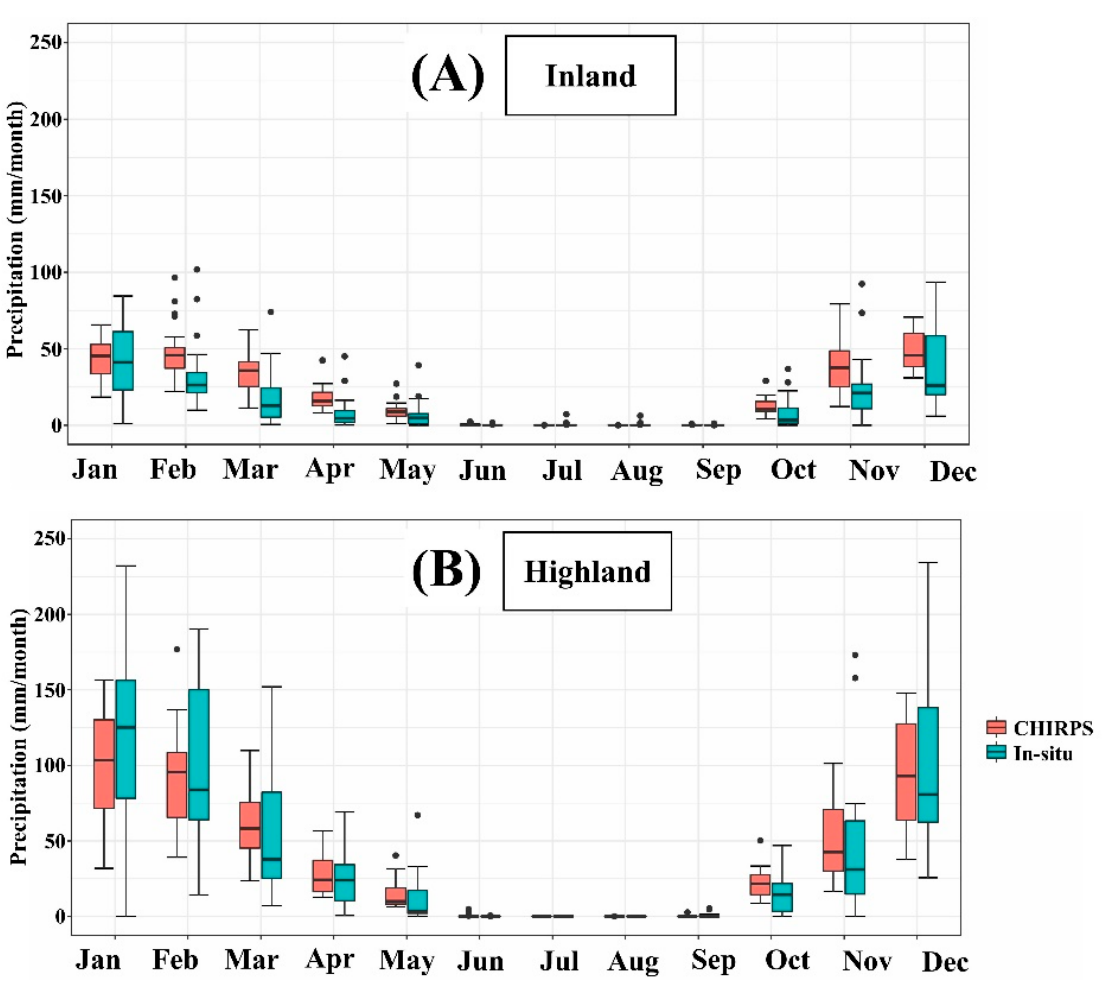
Figure 4. Comparison of CHIRPS monthly precipitation estimates (red boxplots) and in-situ monthly precipitation (blue boxplots). ( A ) Inland average monthly comparison, ( B ) Highland average monthly comparison.